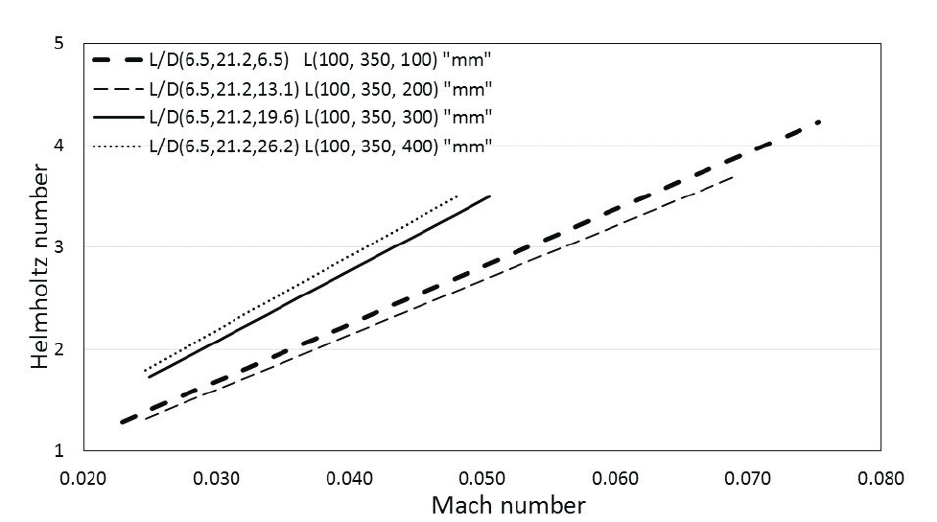
Figure 10. Helmholtz number He plotted against Mach number M for L up = 100 mm, L corr = 350 mm, and L dw = 100–400 mm.